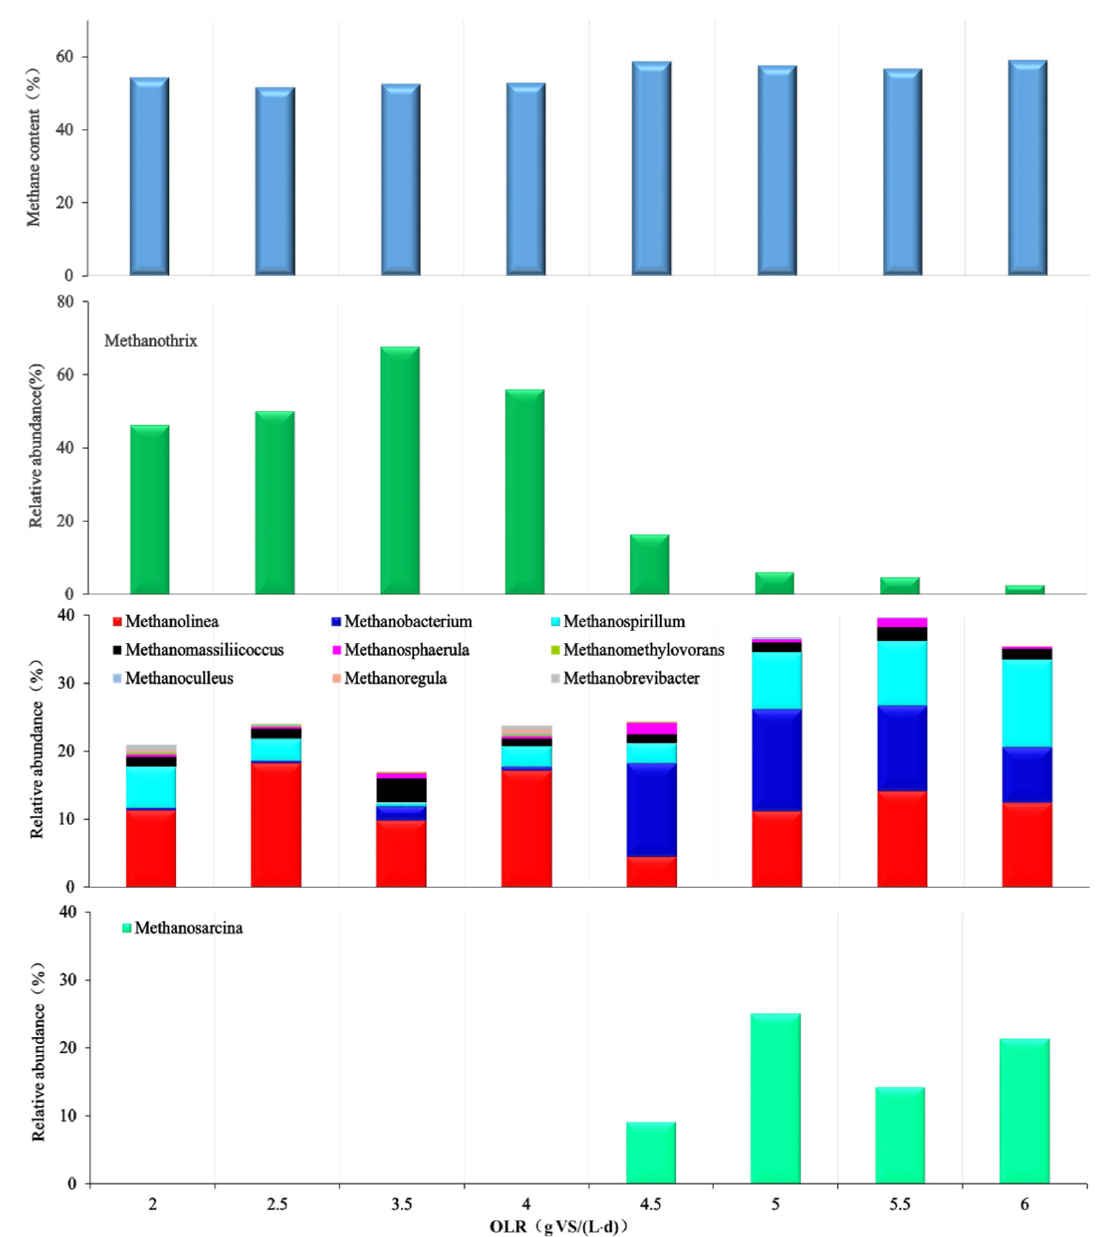
Figure 5. Methane contents and the methanogens in genus level for GM31.